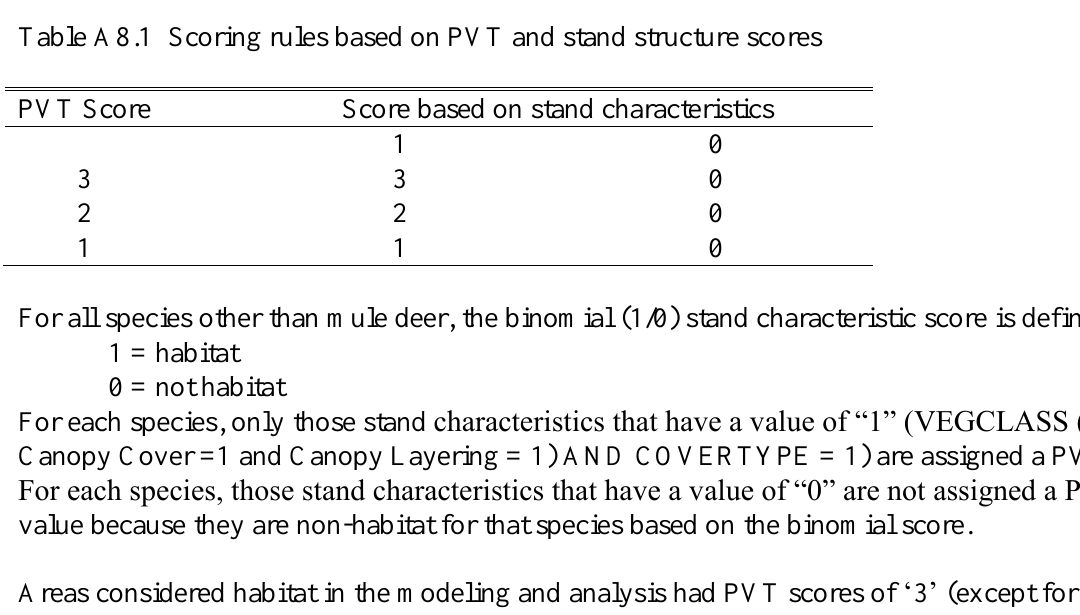
Table A8.2. Canopy Cover Lookup Table . PM=Pacific Marten; BBWO Black-backed Woodpecker; NOGO = Northern Goshawk; PIWO = Pileated Woodpecker; WEBL = Western Bluebird; WHWO = White-headed Woodpecker